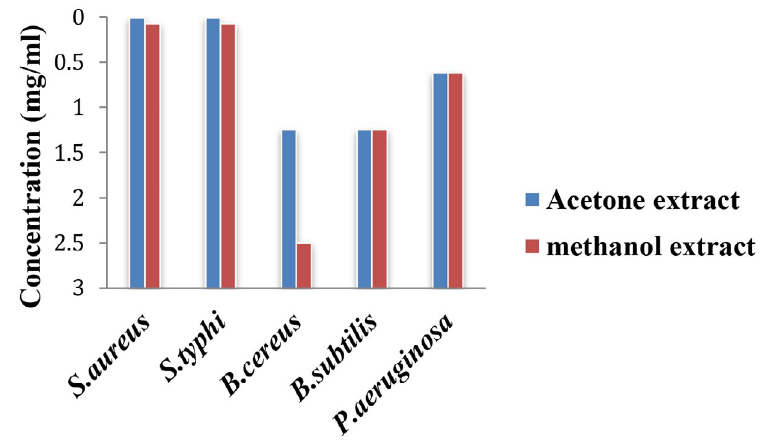
Fig. 5. MIC of active extracts of T. catappa on human pathogenic bacteria .